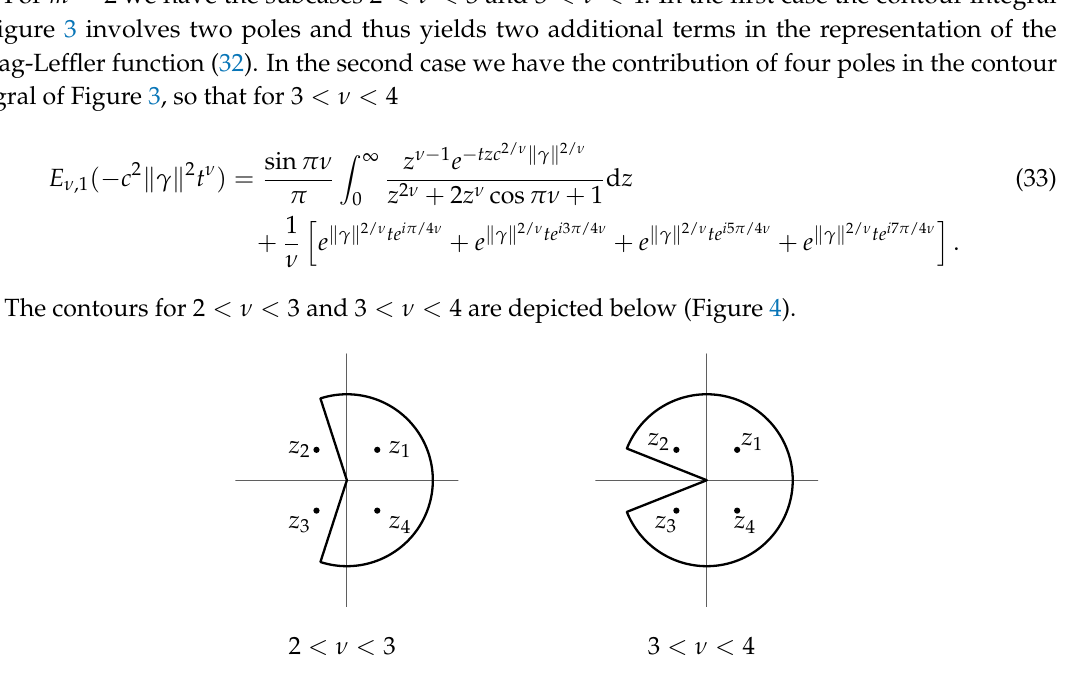
Figure 4. Representation of the contour C (cid:48) for m = 2. The dots indicate the poles of f ( z )